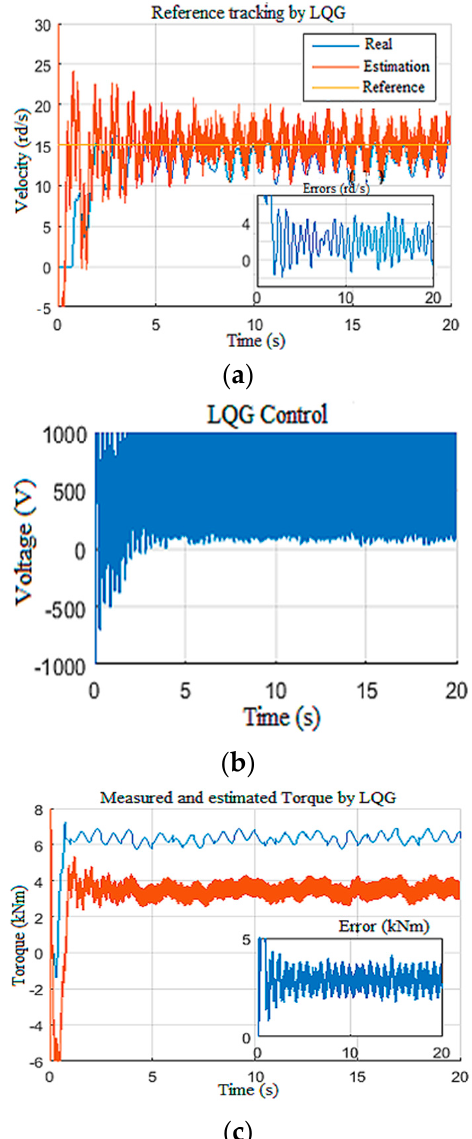
Figure 28. Extreme limitation of LQG responses: ( a ) drill bit velocity; ( b ) voltage; ( c ) the Tob.